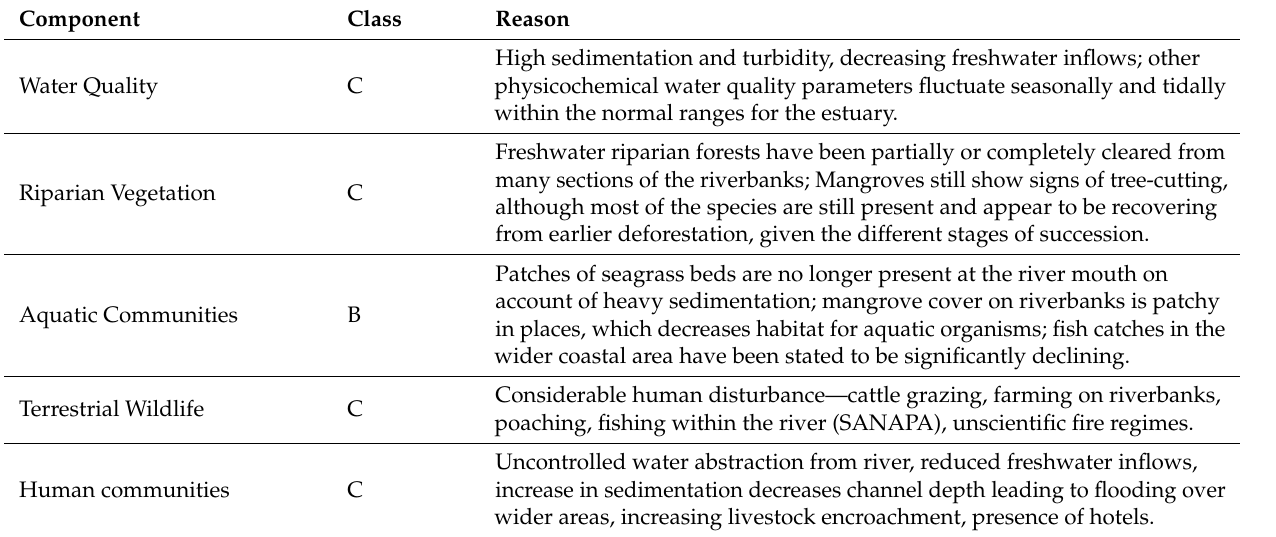
Table 3. Status of various ecosystem components in the Wami Estuary.